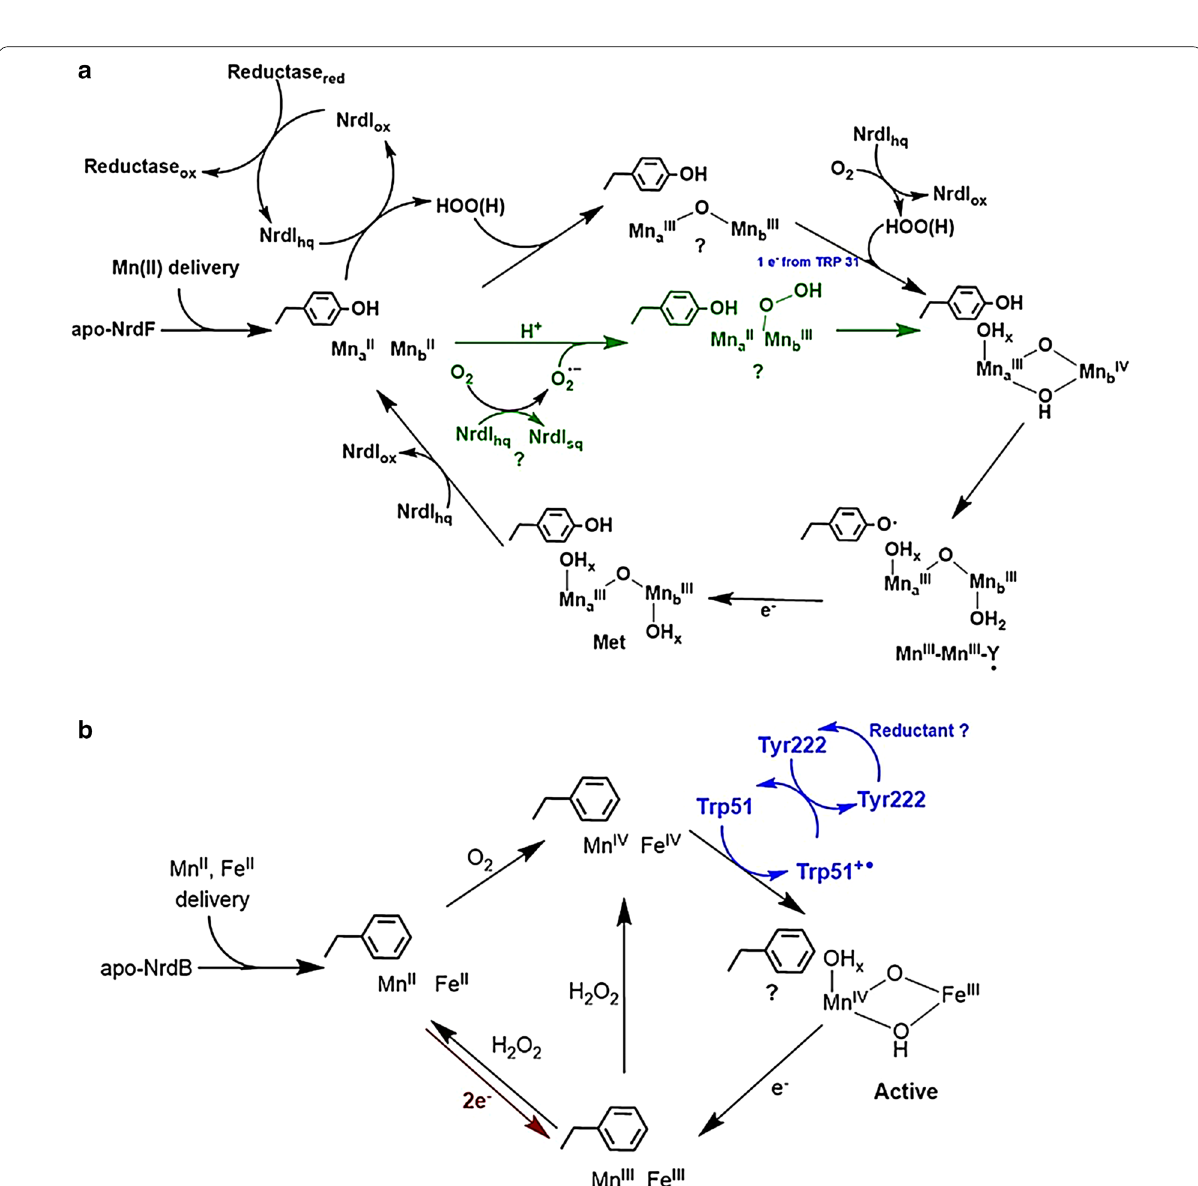
Fig. 4 The proposed reaction cycles for the generation of the tyrosyl radical in a class Ib and b Ic RNR suggested by Stubbe. Redrawn from ref